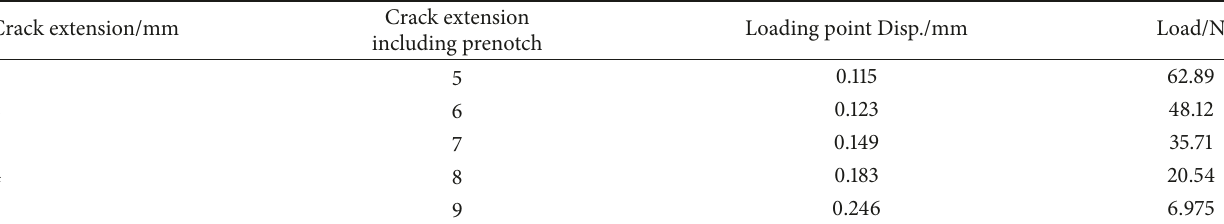
Table 2: FE simulation